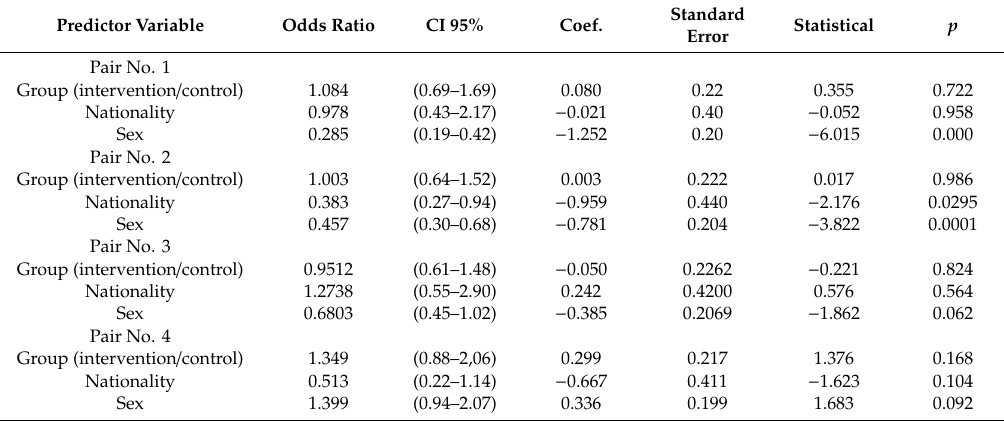
Table 3. Multiple logistic regression model for consumption